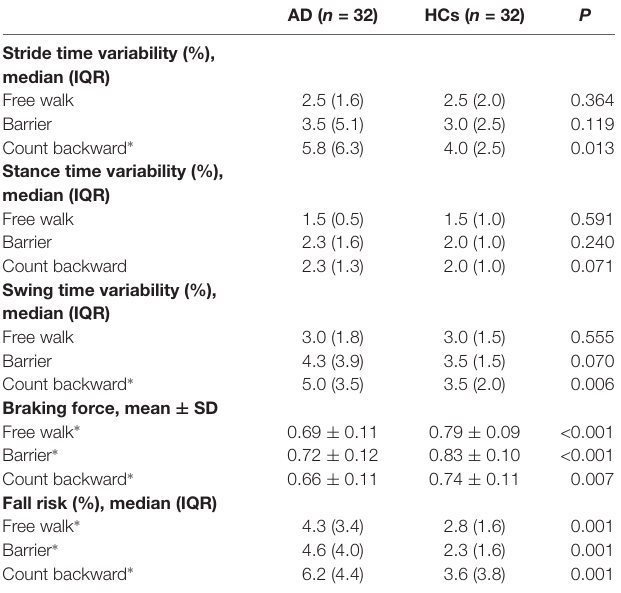
TABLE 2 | Gait parameters of the samples under study.